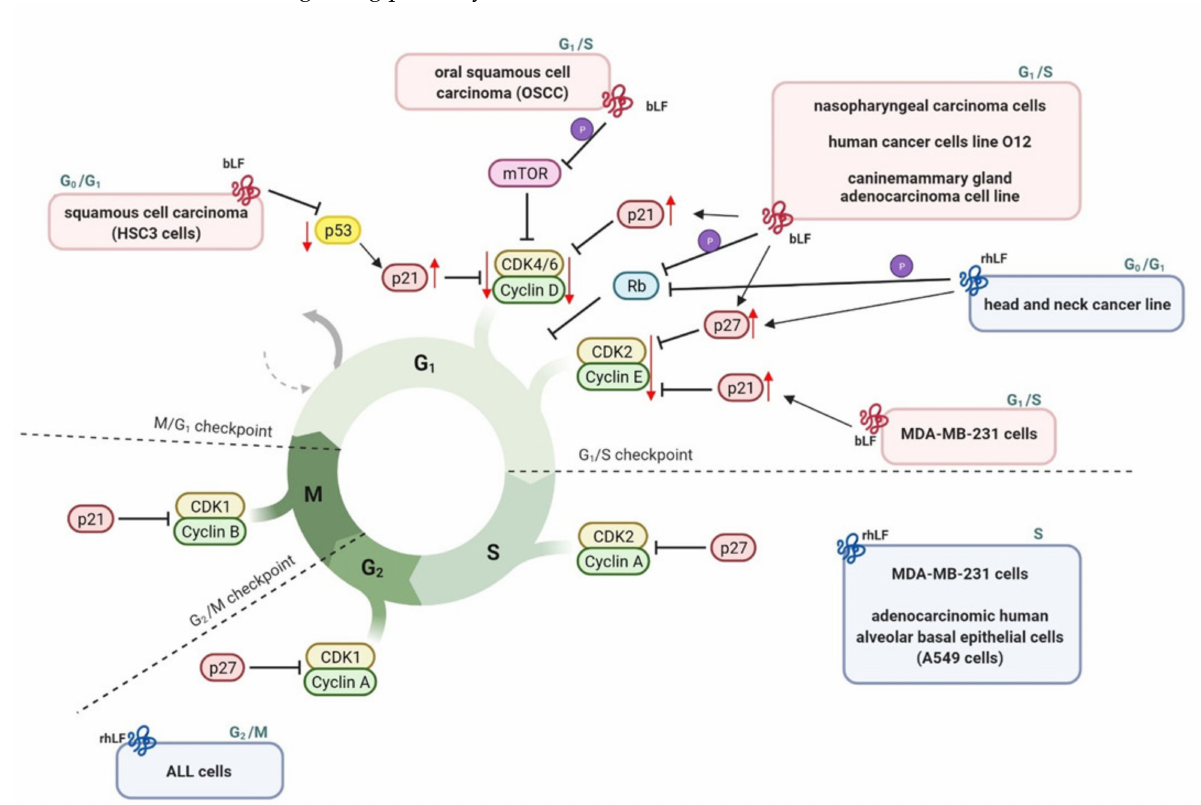
Figure 5. Modulation of cell cycle by bLF and rhLF demonstrated on the example of different cancer cells lines. During the cell cycle, LF can inhibit or activate several checkpoint regulators such as: cyclin-dependent kinase (CDK), and their associated inhibitor partners of the Cip/Kip family proteins (p21, p27), DNA damage response genes (p53) or mTOR/S6K pathway. In response to bLF and rhLF cancer target cells arrest in G 0 /G 1 phase (e.g., HSC3 cells, head and neck cancer line), G 1 /G 2 phase (e.g., OSCC, MDA-MD-231 cells, nasopharyngeal carcinoma cells), G2/M phase (e.g., ALL cells) or S phase (e.g., MDA-MB-231 cells, A549 cells). Key molecules that lead to cell cycle arrest are indicated by the red arrows. Illustration was created in BioRender.com (accessed on 21 April